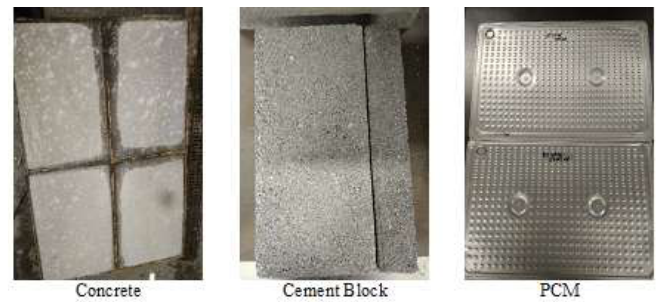
Figure 4. Concrete, cement block and PCM panel used in experimental tests.